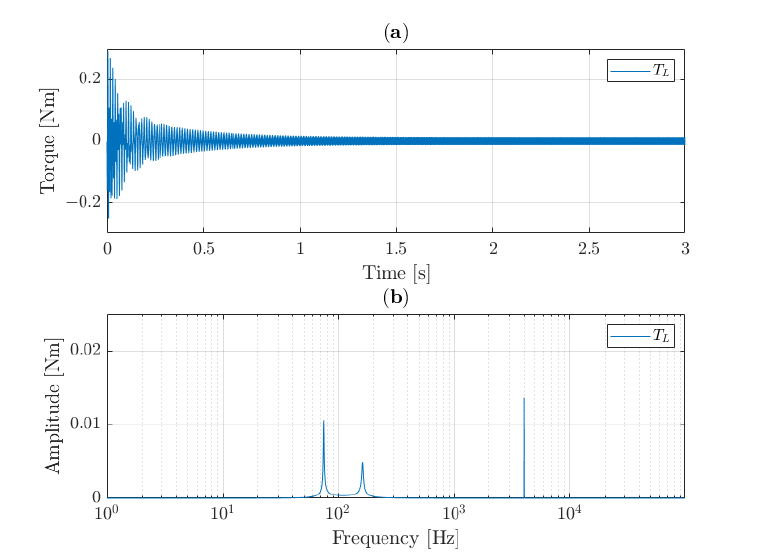
Figure 11. Simulated torque output measured at the load from sinusoidal torque inputs with pulsation of 4 kHz. The second input is shifted with half a period; ( a ) shows the time domain data and ( b ) shows the signal frequency spectrum.